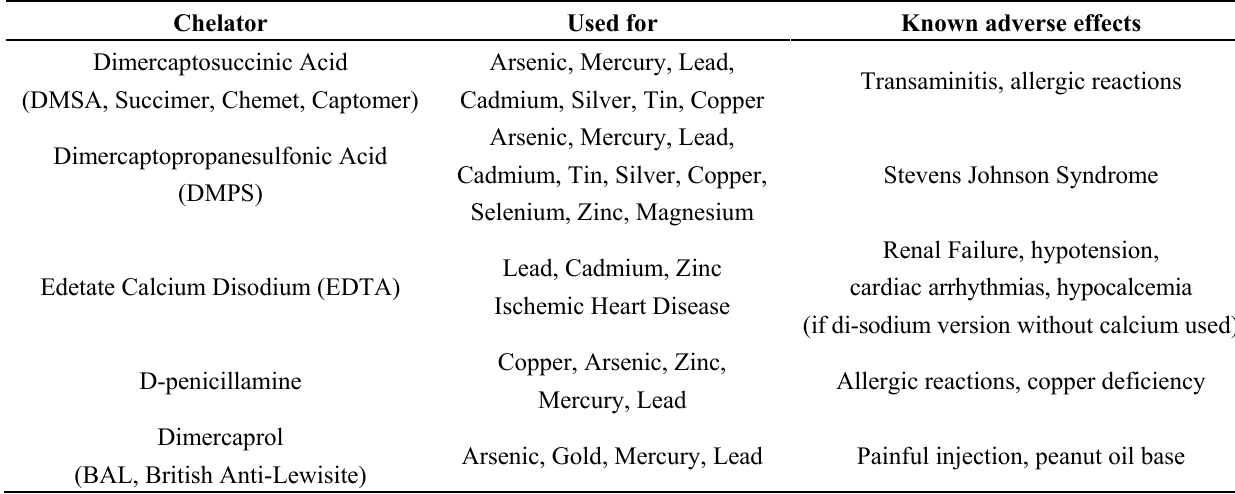
Table 1. Common chelation